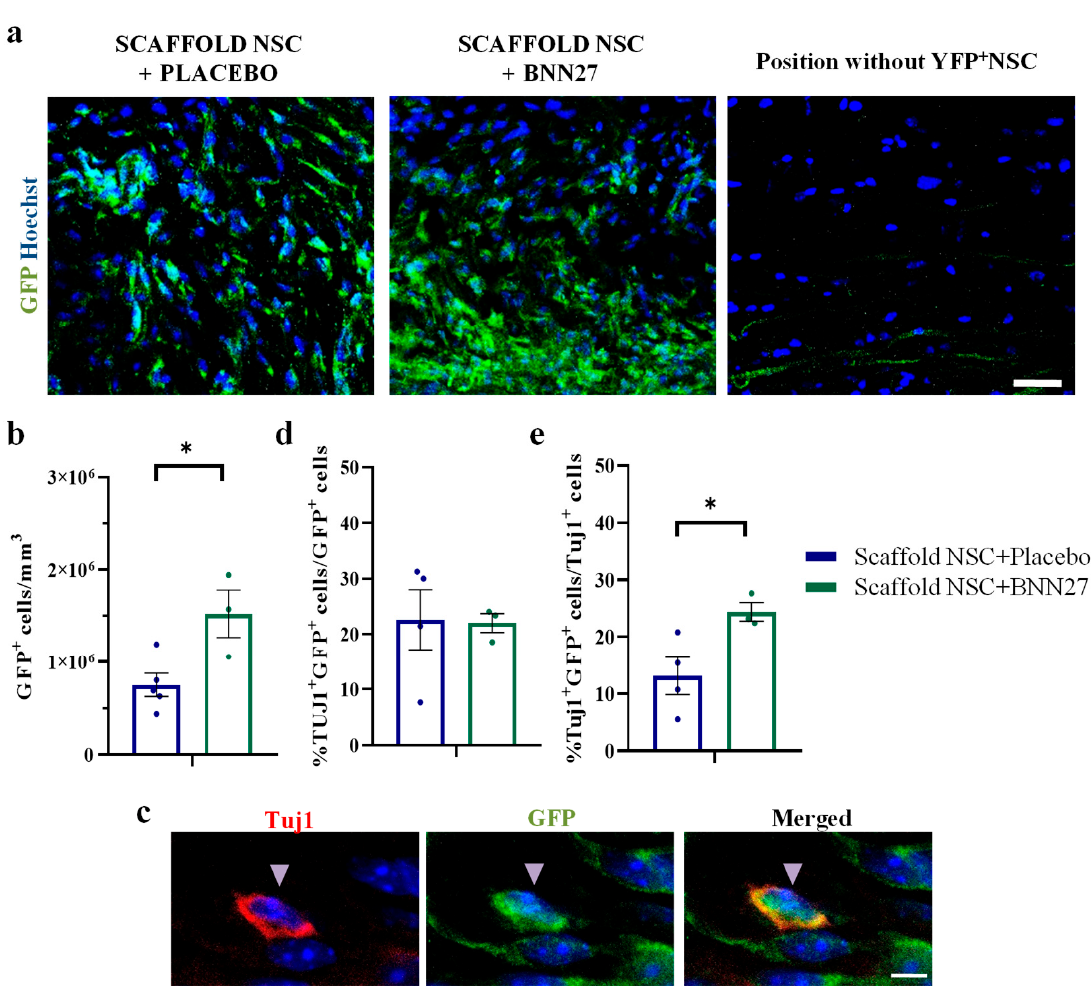
Figure 5. Effects of BNN27 administration on the density and neuronal fate of implanted NSCs. ( a ) Representative high-magnification fluorescence images of GFP + implanted NSC-derived cells from the two animal groups (“Scaffold NSC + Placebo”, “Scaffold NSC + BNN27”) treated with NSC-seeded PCS and a region without implanted NSCs. Scale bar: 30 μ m. ( b ) Quantification of the density of GFP + cells in the lesion epicenter at 12 wpi. ( c ) High magnification fluorescence images of cells within the lesion epicenter double-stained for GFP (green; implanted NSC-derived cells) and Tuj1 (red; neurons). Scale bars: 5 μ m. ( d ) Quantification of the fraction of GFP + cells that also stain for the Tuj1 in the lesion epicenter at 12 wpi. ( e ) Quantification of the fraction of Tuj1 + neurons that also stain for GFP in the lesion epicenter at 12 wpi (“Scaffold NSC + Placebo”: n = 4, “Scaffold NSC + BNN27”: n = 3). Results are presented as mean ± SEM. * p < 0.05; unpaired two-tailed Student’s t-test. BNN27 effects on the density of implanted NSC-derived cells in the lesion epicenter at 12 wpi were evaluated by counting the number of GFP + cells (derived from implanted NSCs) in the two animal groups grafted with NSC-seeded PCS grafts. The results show that BNN27 administration increased the density of GFP + cells in the lesion epicenter (“Scaffold NSC + Placebo”: 7.51 · 10 5 ± 1.25 · 10 5 cells/mm 3 , n = 5 vs. “Scaffold NSC + BNN27”: 15.24 · 10 5 ± 2.57 · 10 5 cells/mm 3 , n = 3, p = 0.02) (Figure 5a,b). In order to evaluate the effects of BNN27 administration on the neuronal fate of implanted NSCs, we counted Tuj1 + GFP + cells in the lesion epicenter (Figure 5c). BNN27 did not affect the fraction of GFP + cells that had differentiated to Tuj1 + neurons (“Scaffold NSC + Placebo”: 22.6 ± 5.4%, n = 4 vs. “Scaffold NSC + BNN27”: 22.0 ± 1.7%, n = 3, p = 0.93) (Figure 5d). However, BNN27 administration increased the fraction of Tuj1 + neurons that originated from implanted